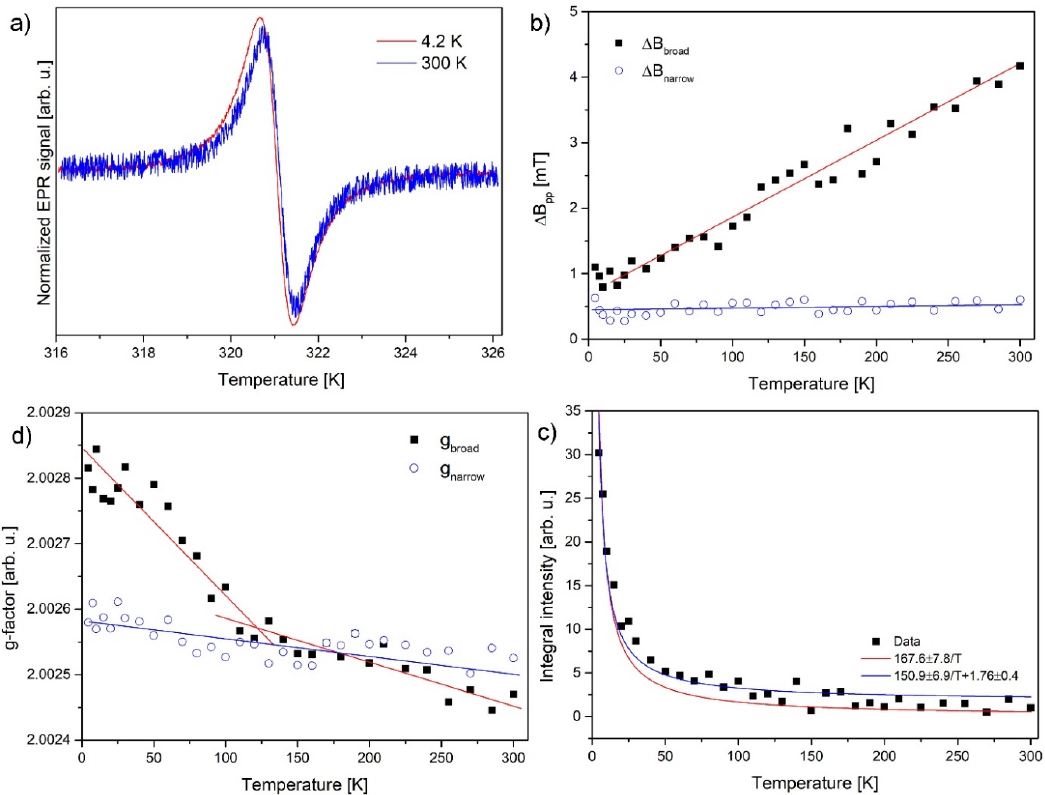
Figure 6. ( a ) Normalized by amplitude electron paramagnetic resonance (EPR) signals recorded at 4.2 and 300 K; ( b ) peak to peak linewidths vs. temperature for two components; ( c ) EPR integral intensity vs. temperature (red and blue curves fits explained in text); ( d ) g-factors vs. temperature for two components (straight lines are only guidelines for eyes).